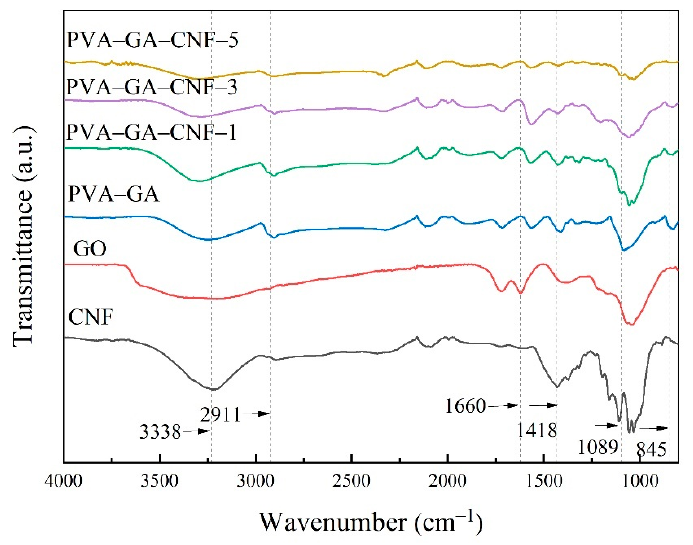
Figure 2. Infrared spectra of GO, CNF, PVA–GA aerogels and PVA–GA–CNF ‐ (1, 3, 5) aerogels .